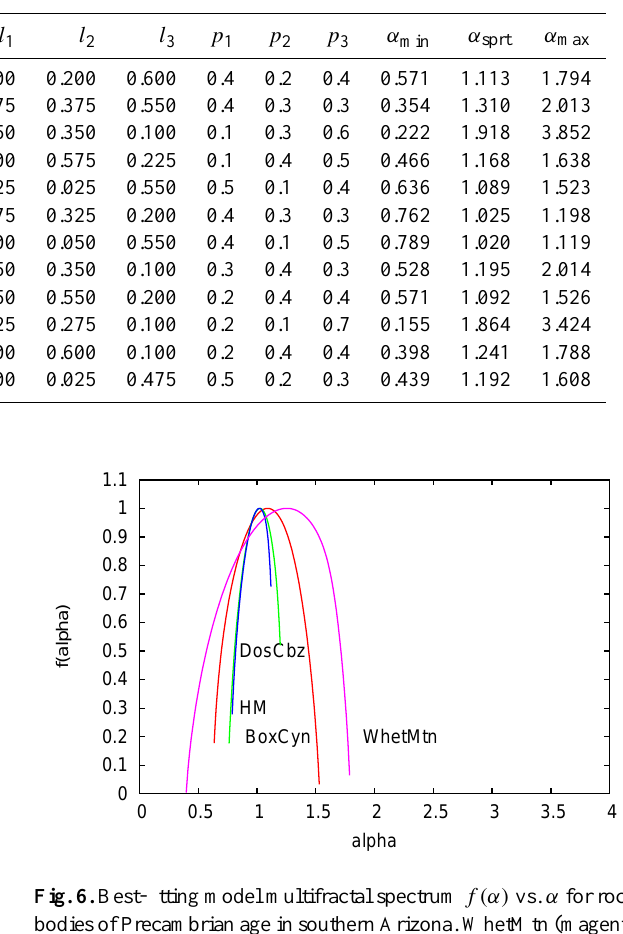
Table 1. Parameters of the best fits to the 12 rock bodies discussed in this report. χ 2 is the reduced chi-square of the fit; MAD is the mean absolute deviation of the fit; l 1 ,l 2 ,andl 3 are the segment length parameters; p 1 ,p 2 ,andp 3 are the relative proportion parameters; α min ,α sprt ,andα max are the Lipschitz-H¨older exponent minimum, support dimension (1.00), and maximum values.